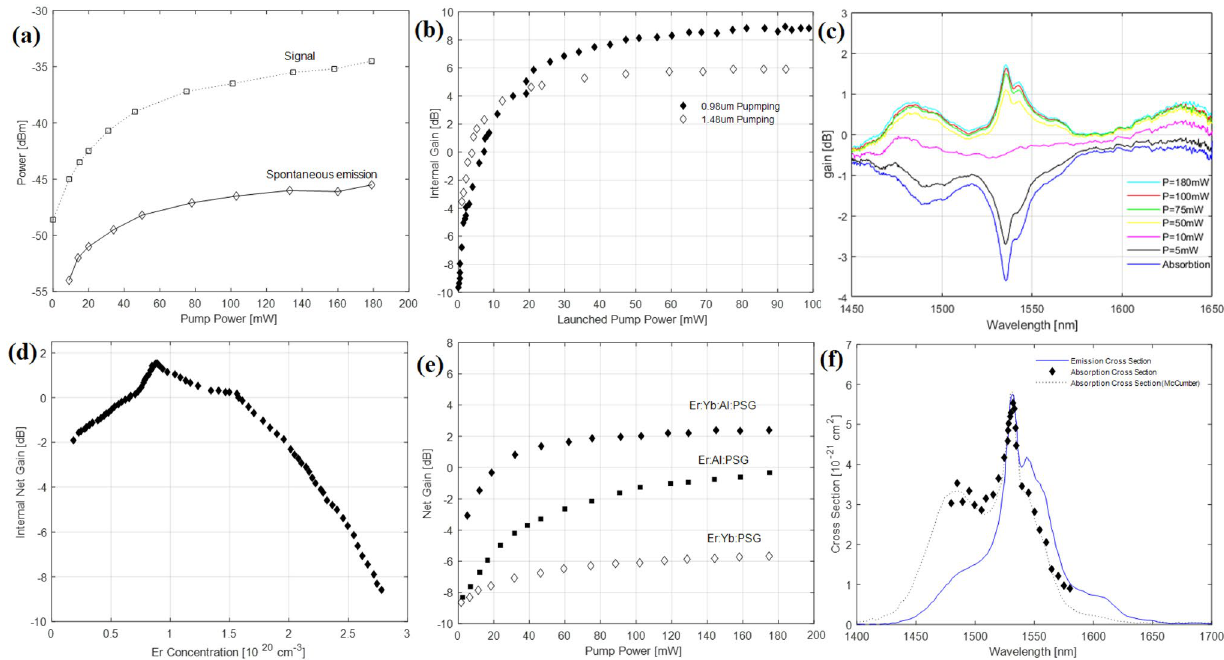
concentration. e Difference of relative gain with pump power for EYDWA with Er:Yb:PSG, Er:Al:PSG and Er:Yb:Al:PSG, respectively from bottom to top. f Absorption cross-section of an Er:Yb:Al:PSG